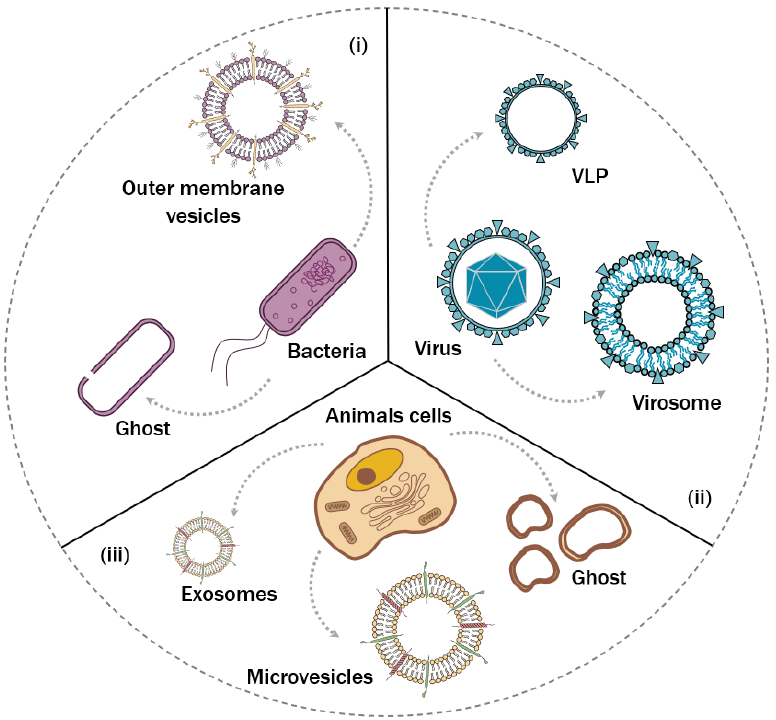
Figure 2. Natural membrane sources and their origin . (i) Outer membrane vesicles are nanovesicles naturally secreted by bacterial culture and ghosts are obtained by removing the internal contents of bacteria. (ii) Viruses are employed to produce virus-like particles (VLPs) or virosomes, the latter by combining their surface protein with commercial lipids. (iii) Mammalian cells are used to produce exosomes and microvesicles, naturally secreted by cell physiology, as well as to obtain cell ghosts by removing their internal